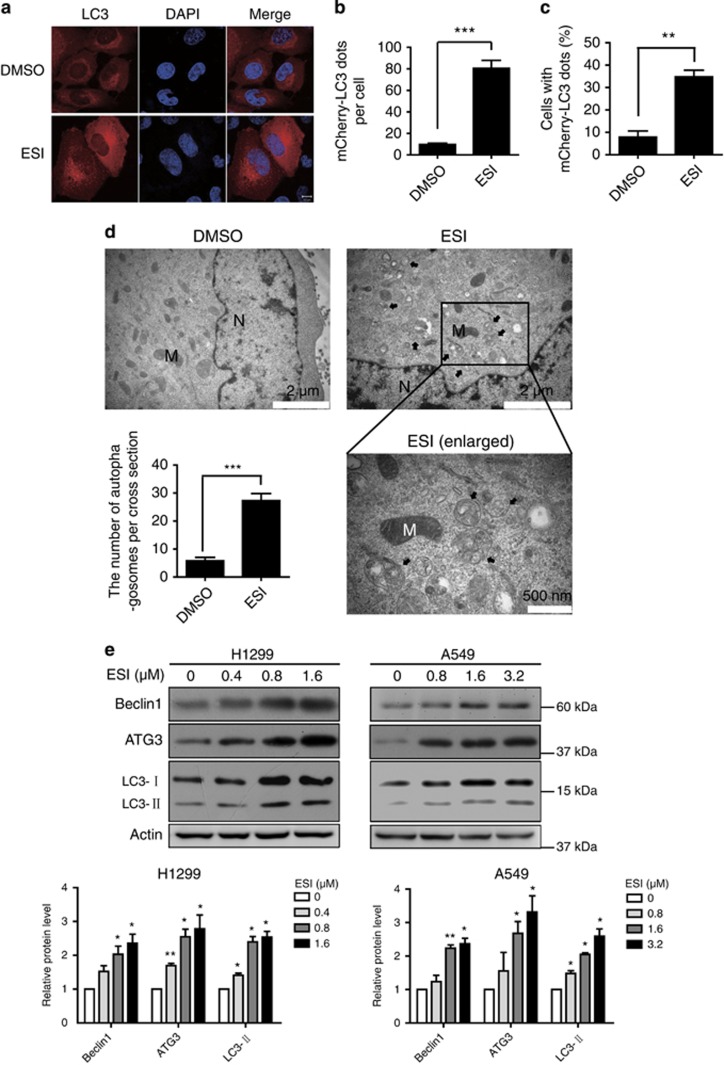
ESI induces the formation of autophagic vacuoles in H1299 and A549 cells. (a) H1299 cells overexpressing mCherry-LC3 were treated with DMSO or ESI (1.6 μM) for 24 h, and the mCherry-LC3 punctate dots in cells were examined. Positive signals were defined if the cells have five or more mCherry-LC3 dots in the cytoplasm. (b and c) The number of mCherry-LC3 dots per cell (b) and the percentage of the cells with mCherry-LC3 dots (c) were counted under florescence microscope. (d) Ultrastructural features of the H1299 cells treated with ESI (1.6 μM) for 24 h were analyzed by electron microscopy. The typical images of nucleus (N), mitochondria (M) and autophagosomes (arrows) were shown at higher magnification. The number of autophagosomes in H1299 cells was presented. Twenty cross-sections were counted in each experiment. (e) H1299 and A549 cells were treated with DMSO or indicated concentrations of ESI for 24 h, and then compared for expression levels of Beclin1, ATG3 and LC3 by western blot. Actin was included as loading control. All data were representative of three independent experiments. Bars, S.E.M.; *P<0.05, **P<0.01, ***P<0.001